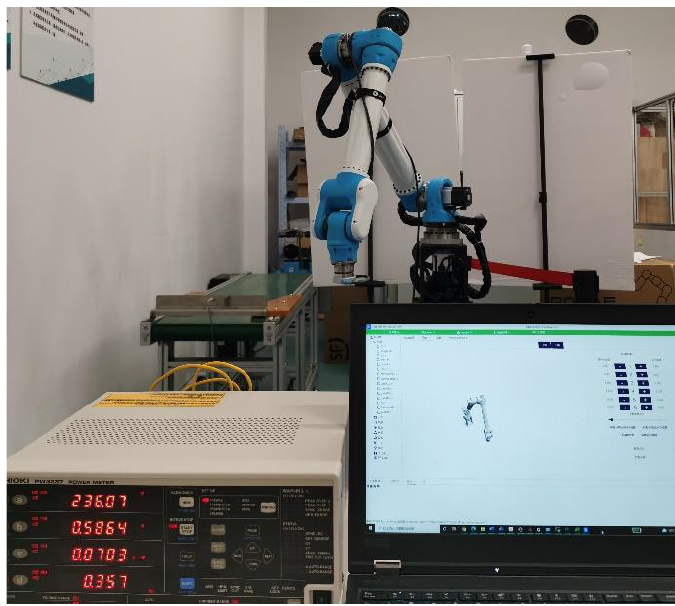
Figure 9. Experiment platform of six-joints robot.